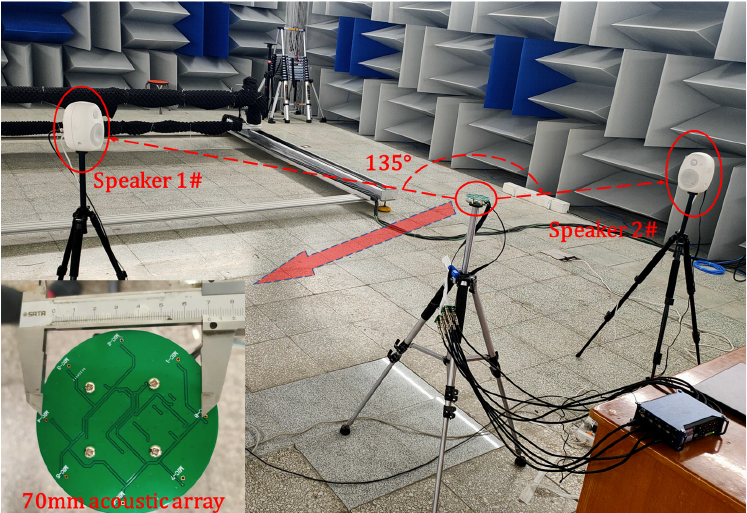
Figure 7. The settings of the semi-anechoic chamber experiment.